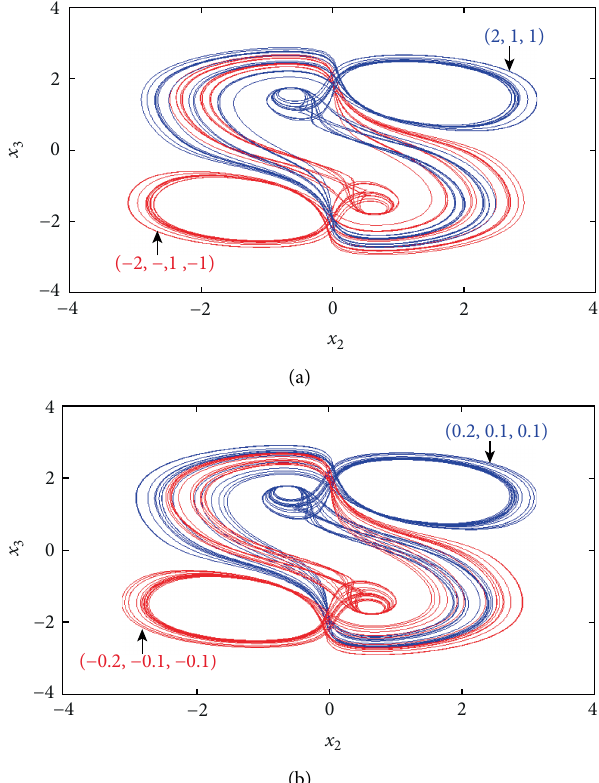
Figure 1: Coexistence of two kinds of three-scroll chaotic